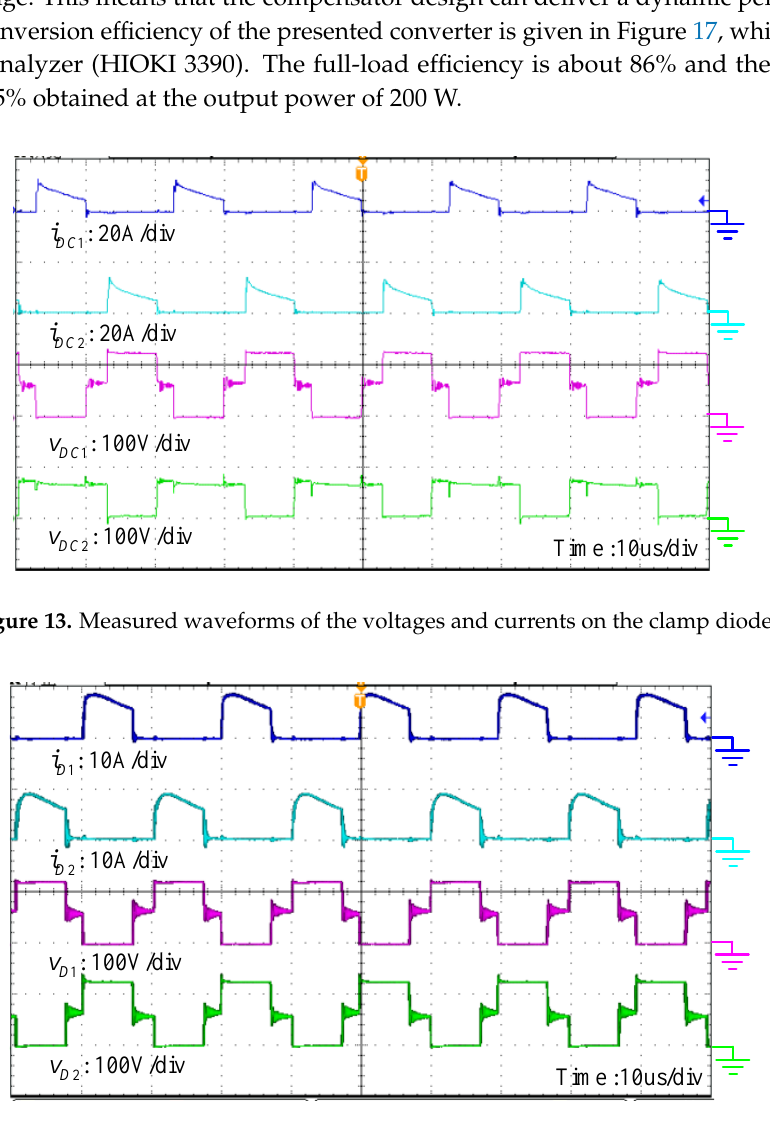
10us/div :Time Figure 15. Measured waveforms of the voltages and currents on the switched diodes. In order to obtain a regulated and constant output voltage in spite of input voltage variation and output load disturbance, the closed-loop control with type III compensator is implemented [23]. There are three poles (one at the origin) and two zeros provided by this compensation. The experimental result under the step load change from half load 500 W to full load 1000 W and vice versa is illustrated in Figure 16. It can be seen that the transient voltage ripple of the output voltage